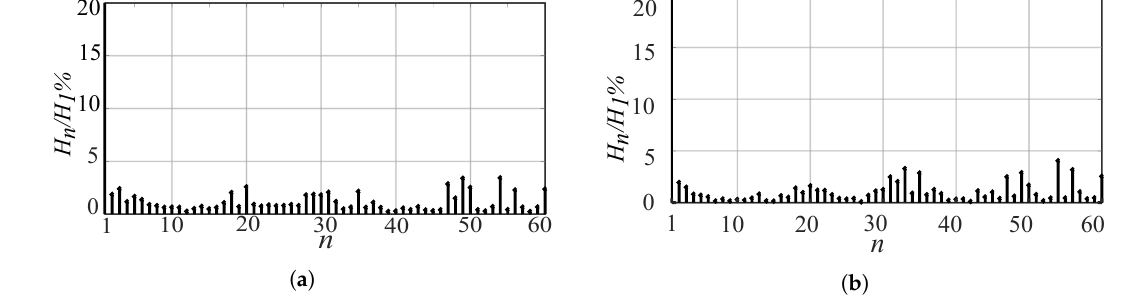
Figure 4. FFT of the output phase voltage: ( a ) 7-level inverter. ( b ) 9-level inverter.